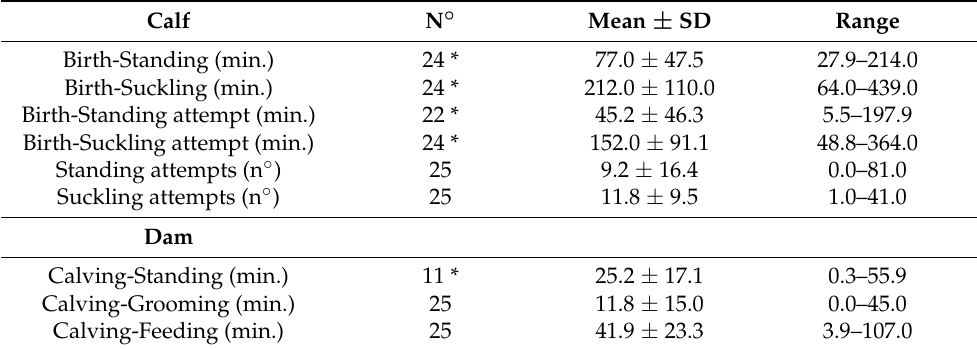
Table 2. Latency between birth and the first behavioural activities for the calf and the